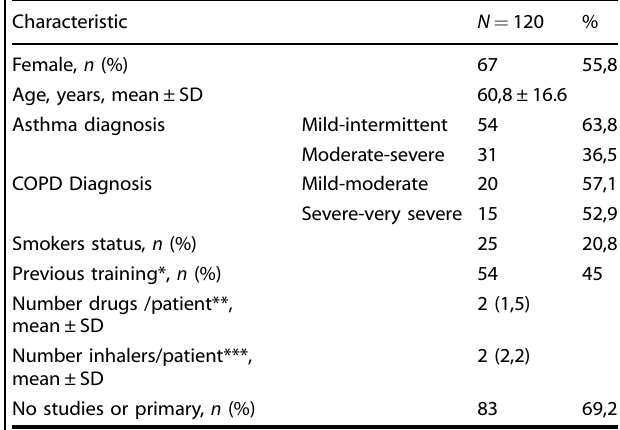
Table 1. Baseline characteristics of patients in the initial visit ( n =